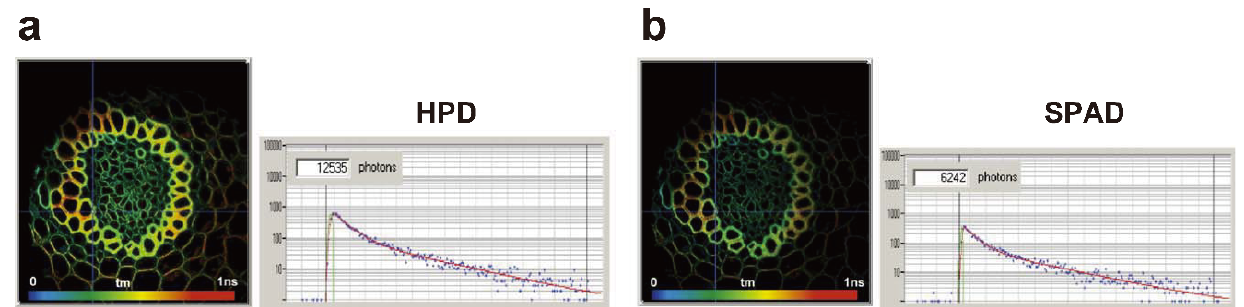
Figure 12. FLIM images acquired by HPD ( a ) and SPAD ( b ). Adapted with permission from [13].